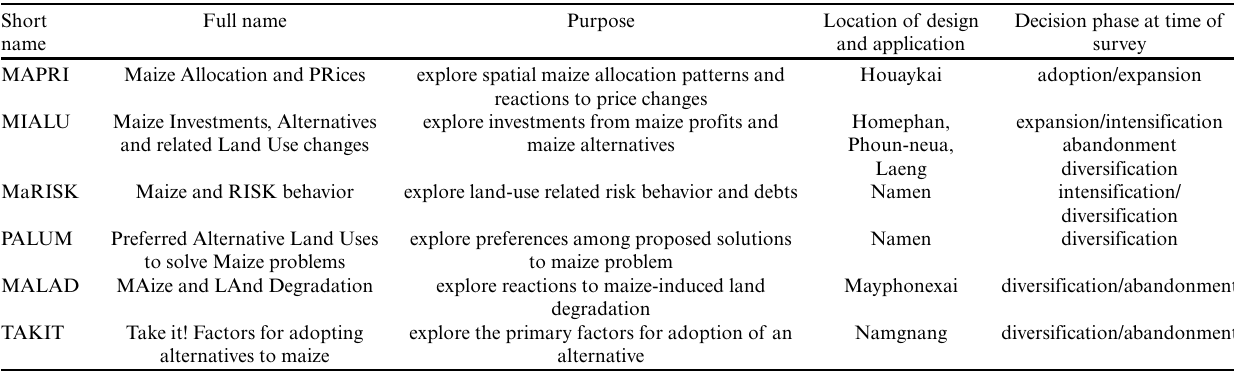
Table 2 . List of local serious games developed and applied in respective case study